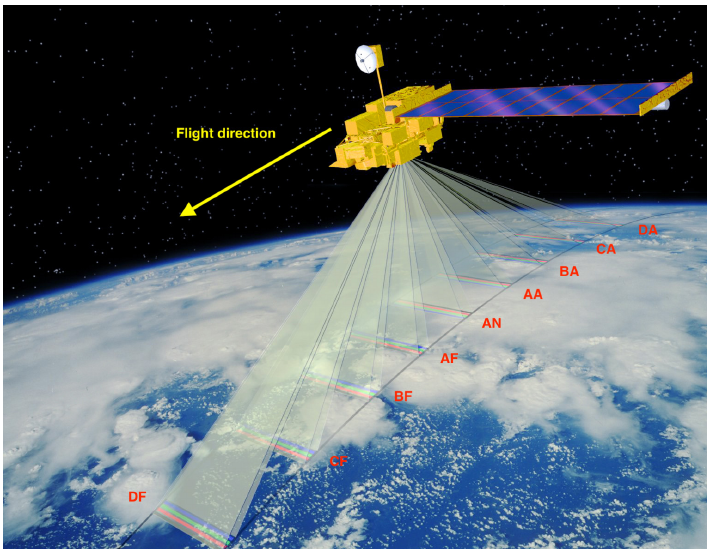
Figure 1. Artist’s rendition of the MISR’s observational protocol, with nine cameras pointing in different directions along-track, each featuring four spectral bands. Image courtesy of Shigeru Suzuki and Eric M. De Jong, Solar System Visualization Project. Source: JPL image